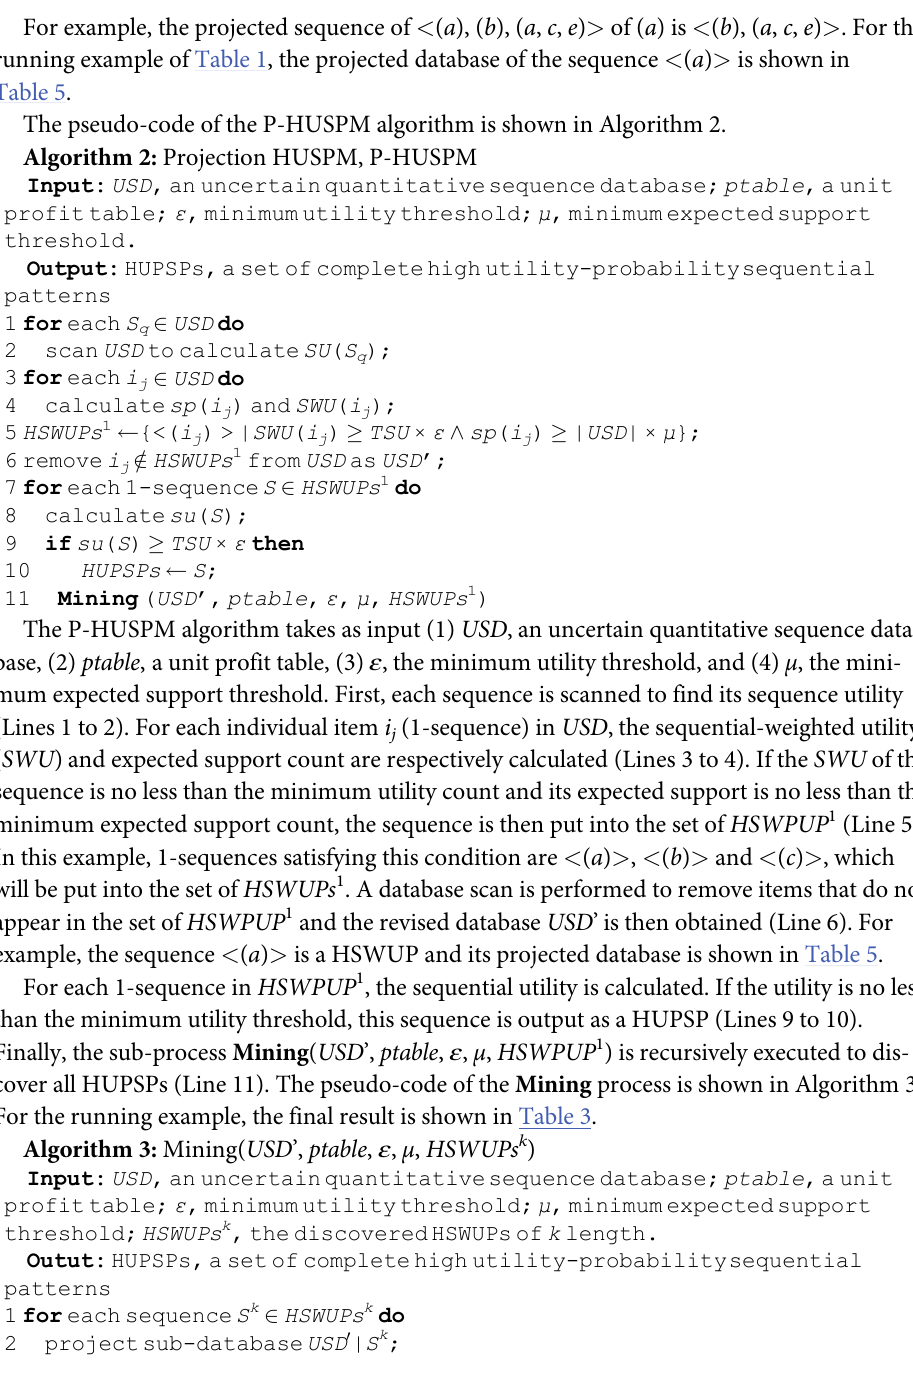
Algorithm 3: Mining( USD ’, ptable , ε , μ , HSWUPs k